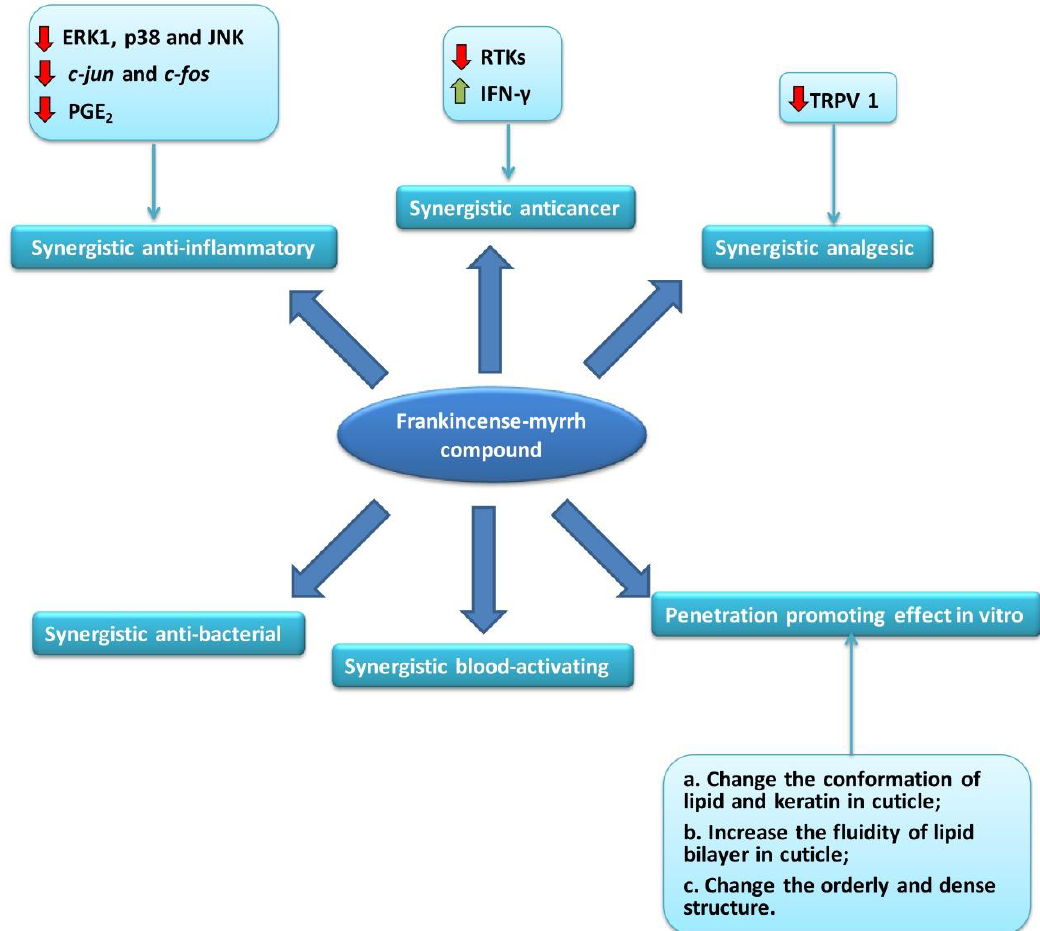
Figure 5. The pharmacological effects and mechanisms of frankincense – myrrh compound.